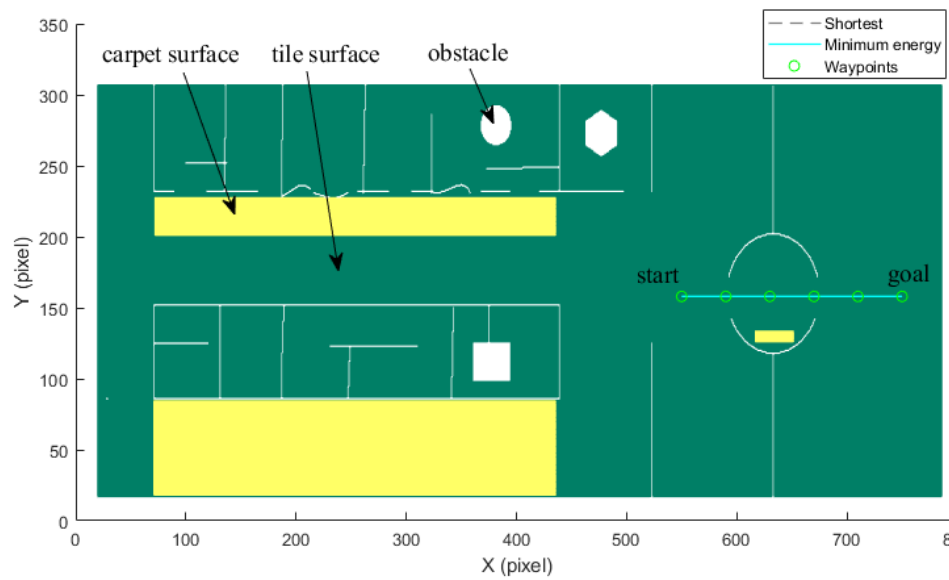
Figure 15. Optimal trajectory based on minimum energy in the circle region. Table 6. Simulation results in case (3).